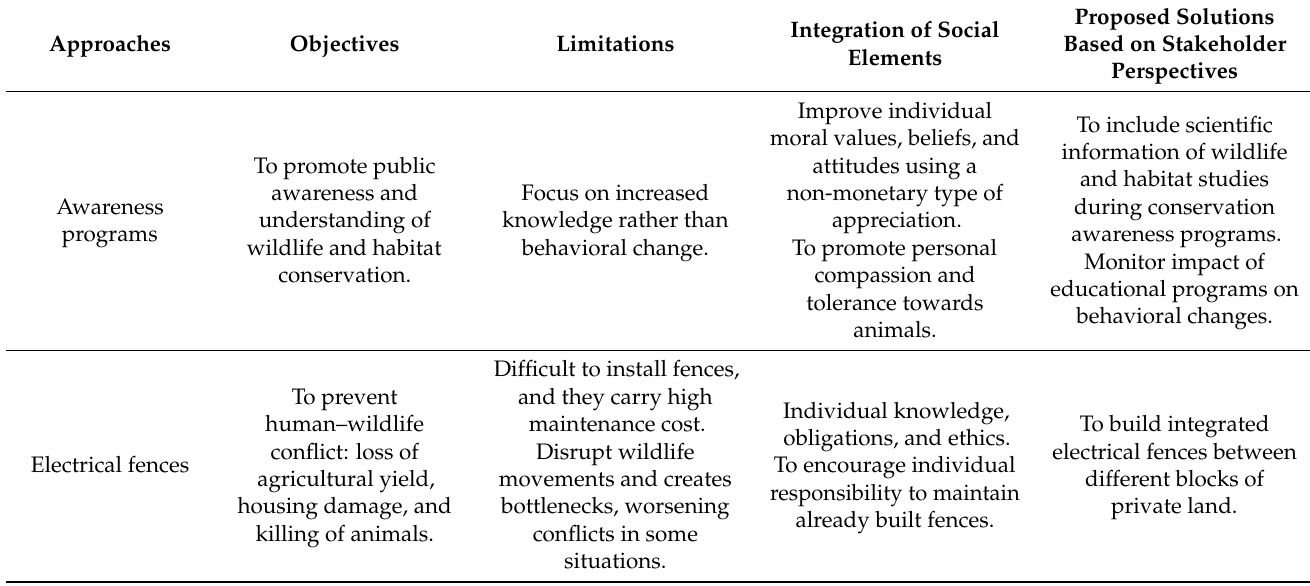
Table 3. Main approaches, barriers, and recommendations to improve wildlife